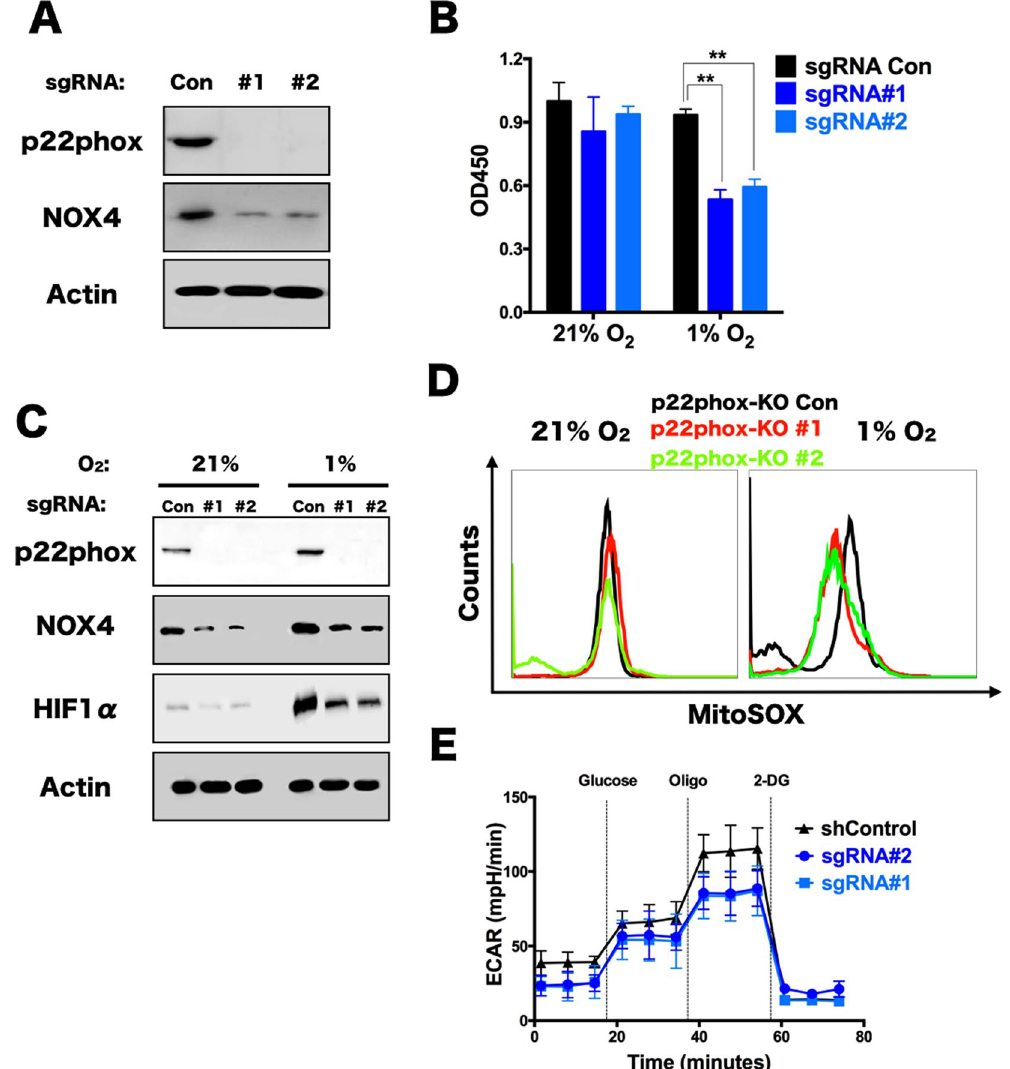
Figure 4. p22phox is essential for NOX4 expression and TPC-1 proliferation. ( A ) Immunoblots of p22phox knockout cells and its Control in TPC-1. ( B ) Viability assay for TPC-1 cells expressing sgRNA control(LentiCRIPSR V2.0) or sgRNA against p22phox (#1, #2) which were cultured in normoxia (21% O 2 ) and hypoxia (1% O 2 ) respectively for 48 hours using CCK8 assay (n = 8). ** P < 0.01. ( C ) Immunoblots of p22phox knockout cells and its Control respectively cultured under 21% O 2 and 1% O 2 for 48 hours. ( D ) Mitochondrial ROS level was measured with MitoSox staining by flow cytometry analysis in TPC-1 cells expressing sgRNA control (LentiCRIPSR V2.0) or sgRNA against p22phox (#1, #2) cultured in 1% O 2 for 48 hours. ( E ) ECAR was measured in TPC-1 cells expressing sgRNA control (LentiCRIPSR V2.0) or sgRNA against p22phox (#1, #2) cells treated with 1% O 2 (48 hours). Data show a representative experiment (from 3 independent experiments). Error bars ± SD (n =